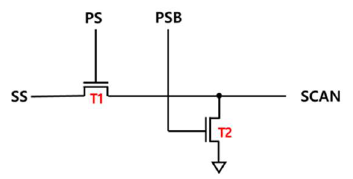
Figure 4. Unit scan drive circuit with two switch TFTs. Table 1. Comparison of driving characteristics of the proposed circuit and 2TFT circuit. 2T Scan